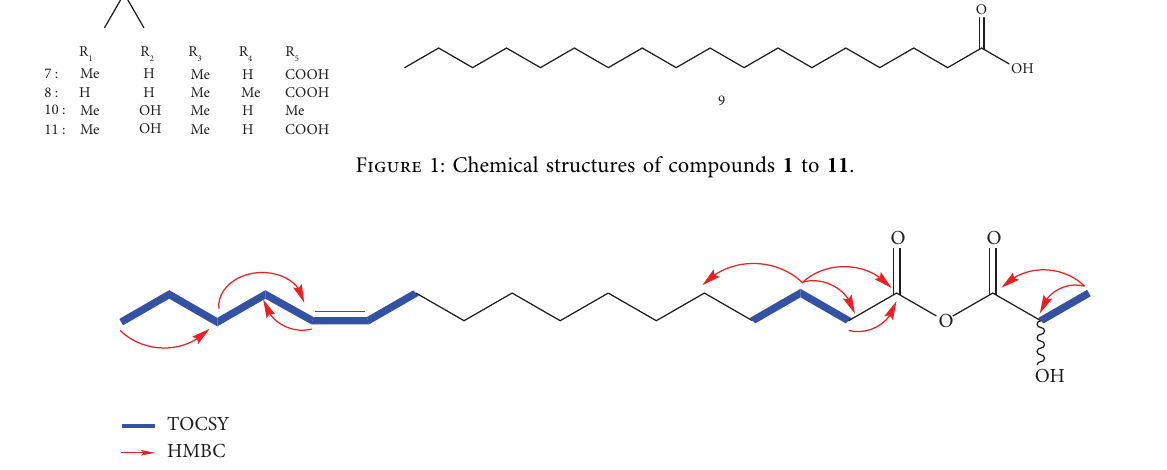
Figure 2: TOCSY and HMBC correlations of compound (1) .